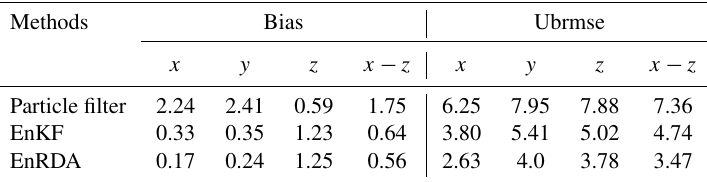
Table 1. Expected values of the bias and ubrmse for the particle filter (PF), ensemble Kalman filter (EnKF), and ensemble Riemannian data assimilation (EnRDA) for 50 independent simulations of Lorenz-63 across all problem dimensions. Methods Bias Ubrmse x y z x − z x y x − z Particle